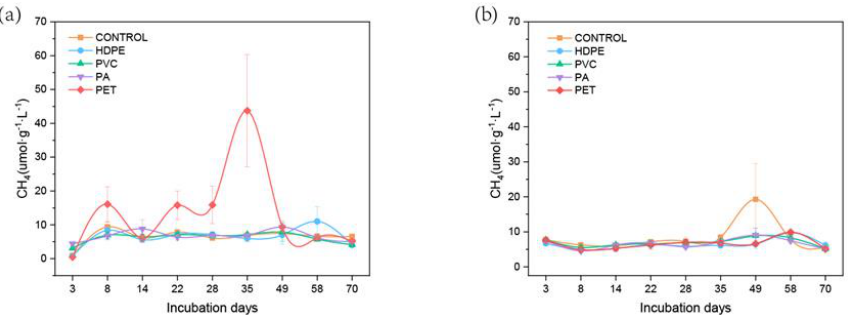
Figure 4. CH 4 concentrations in saltwater ecosystem after microplastics (HDPE, PVC, PA, PET) were added. ( a ) salt marsh ( b ) mangrove forest.